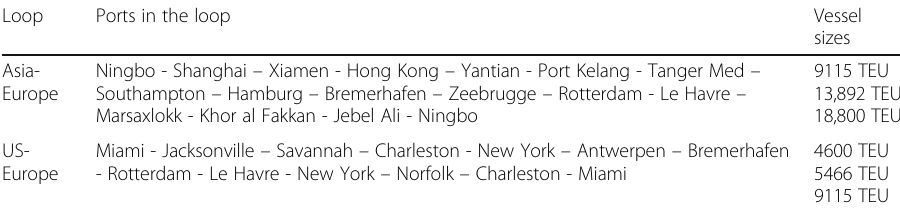
Table 12 Ports in the loop of each route a